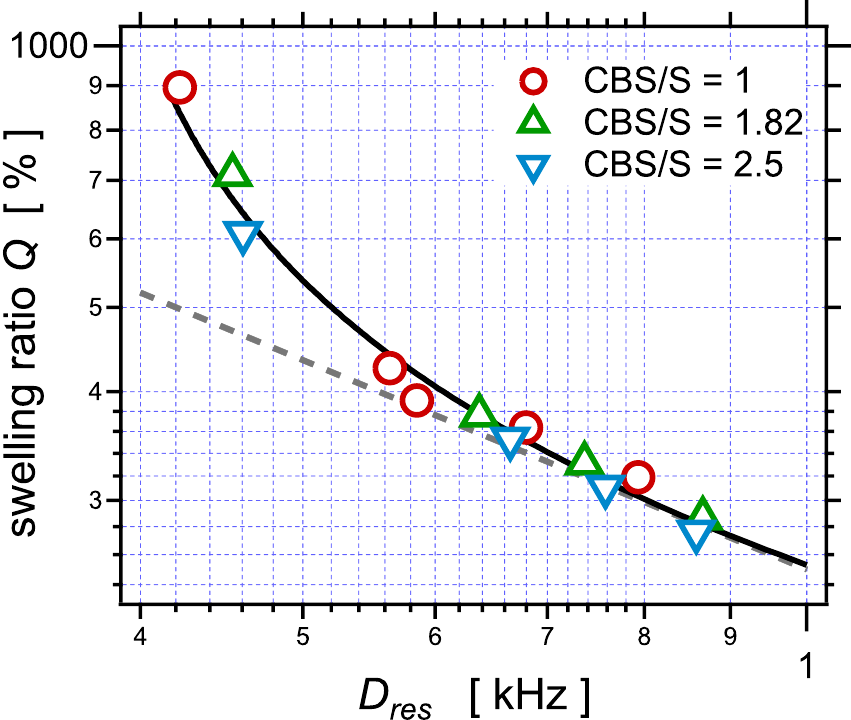
Figure 6. The equilibrium swelling ratio Q (in vol%) as a function of the NMR parameter D res , for the series of samples with different amounts of sulfur and different sulfur/accelerator ratios. The plain curve is a fit of the full set of data with the Flory–Rehner equation (Equation (11)), taking the assumption of phantom network, as described in the